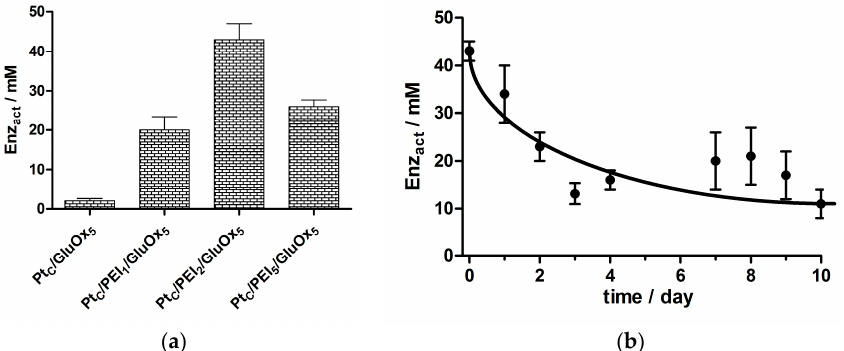
Figure 2. Initial studies using recombinant GluOx in combination with PEI, but without a permselective barrier or crosslinking agent: ( a ) Comparison of day-0 HP-normalized J max value (Enz act ; see Equation (7)) for Pt C /PEI X /GluOx 5 designs, with x = 0, 1, 2 and 5 (see text for